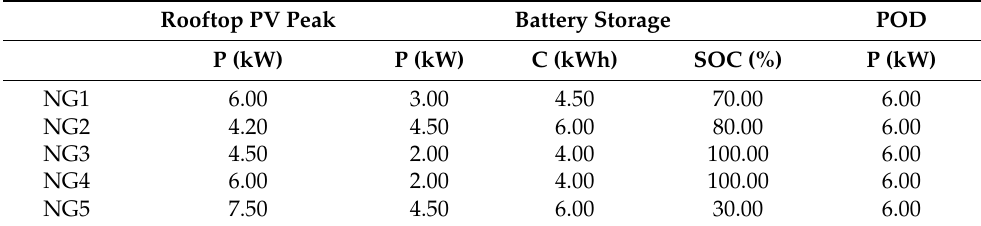
Table 2. Technical data for the generation and battery storage.